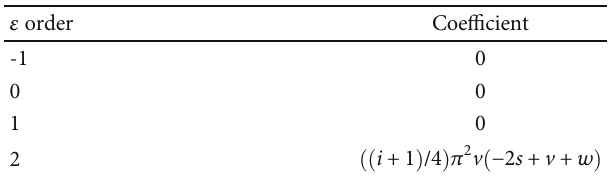
Table 3: A 3 ε series ½ 1, 2 (cid:3)